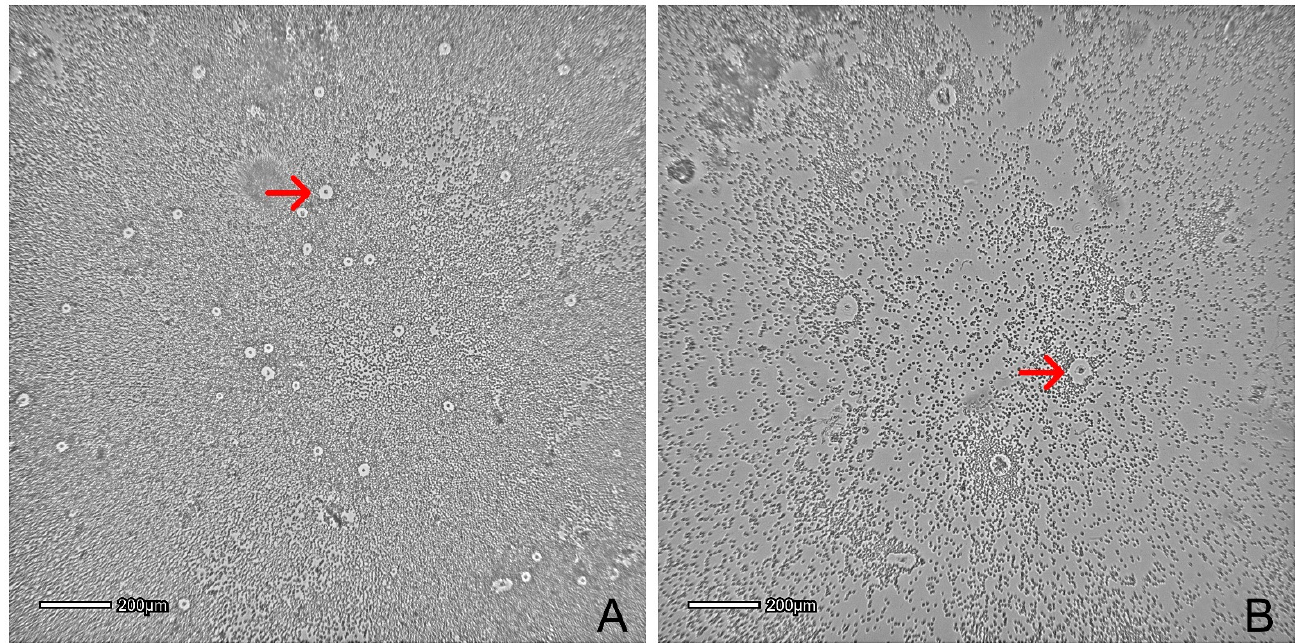
Figure 3. ( A , B ) represent stromal vascular fraction 24 h post isolation from peri-ovarian and subcu- taneous adipose tissue, seeded in T25 flask after mechanical and enzymatic disruption. Cells pointed with a red arrow are plastic adherent cells in expansion; the surrounding cells are nonadherent. Pictures were obtained with Cytosmart Lux2 (CytoSMART Technologies B.V., The Netherlands).